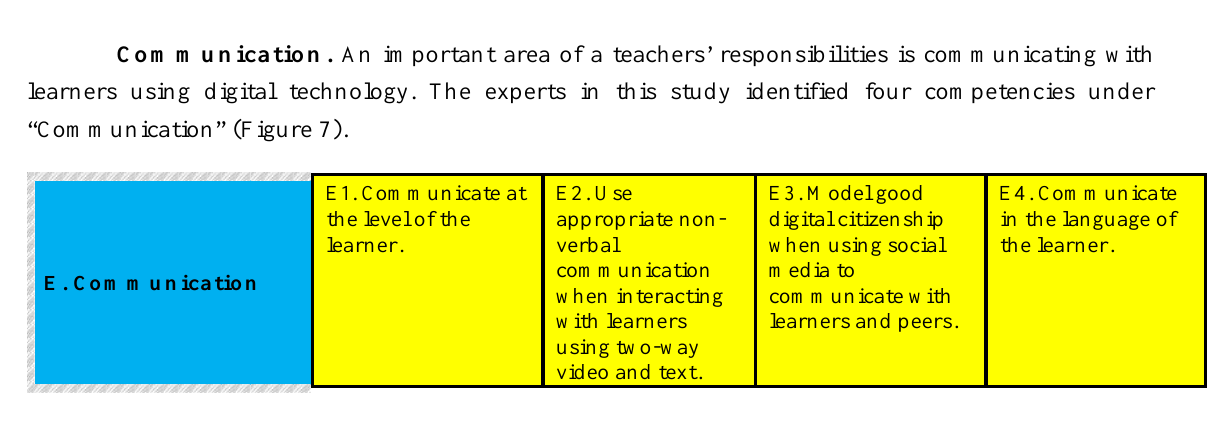
Figure 7. Communication competencies for the digital